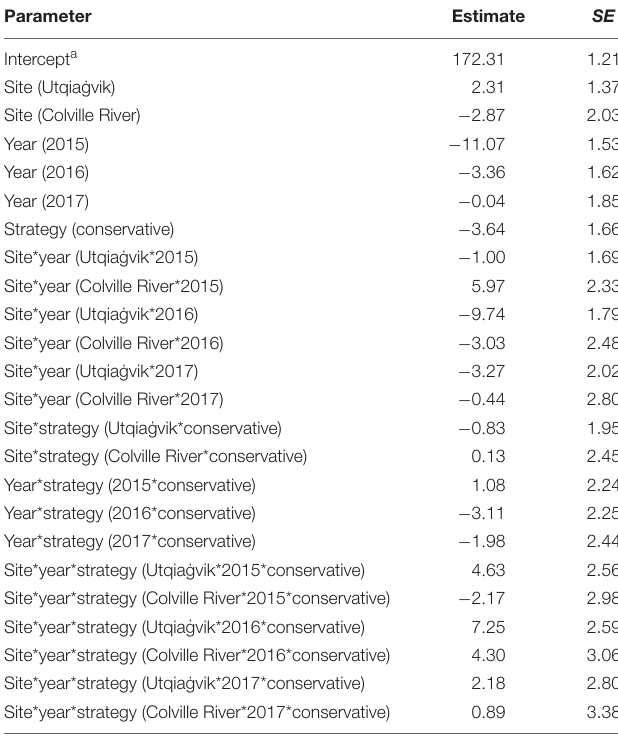
TABLE 3 | Top-ranked models (plus intercept-only model) explaining variation in initiation dates of shorebird nests at Utqia˙gvik, Colville River, and Prudhoe Bay, 2015–2018.